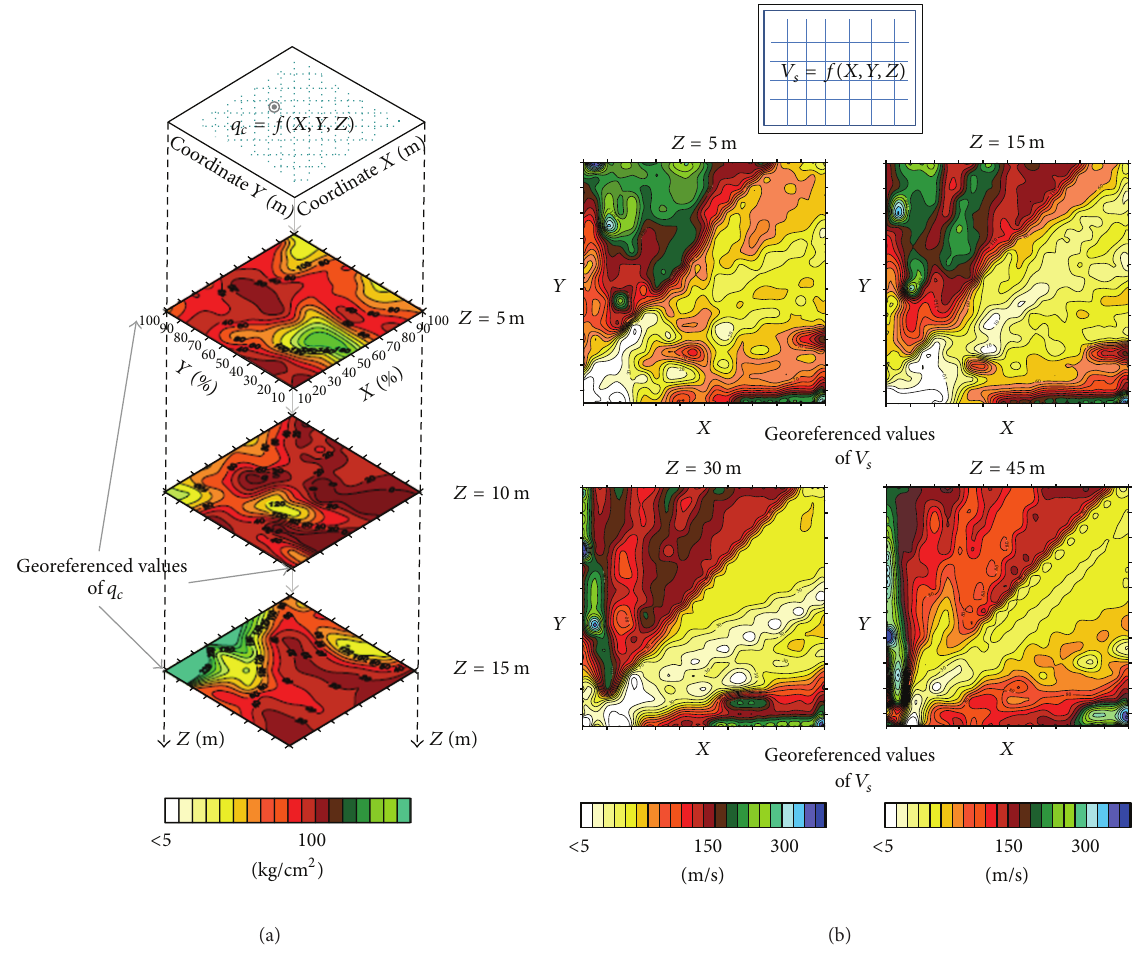
Figure 8: Isovalues curves for 𝑞 𝑐 and 𝑉 𝑠 .